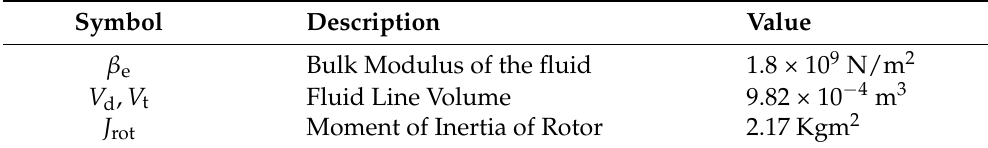
Table 2. System parameters in the dynamic